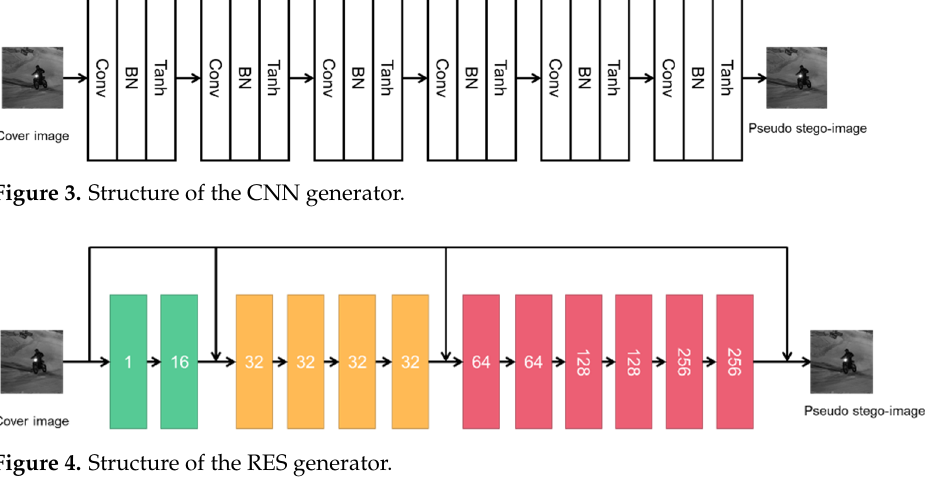
Figure 2. Structure of the fully connected generator.